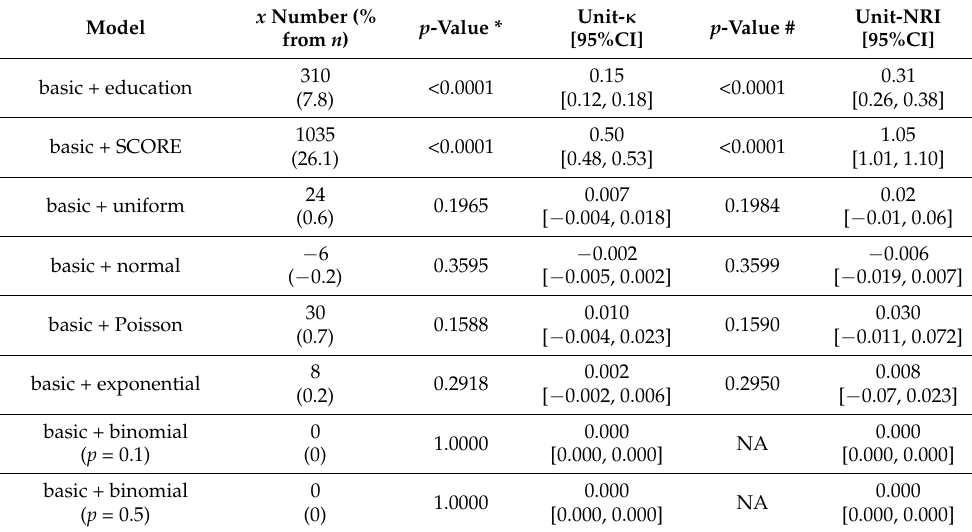
Table 7. Reclassification quality based on Cohen Kappa and Net Reclassification Improvement (NRI) for a change of CVD risk (between the base and extended logistic regression models) exceeding 1%.